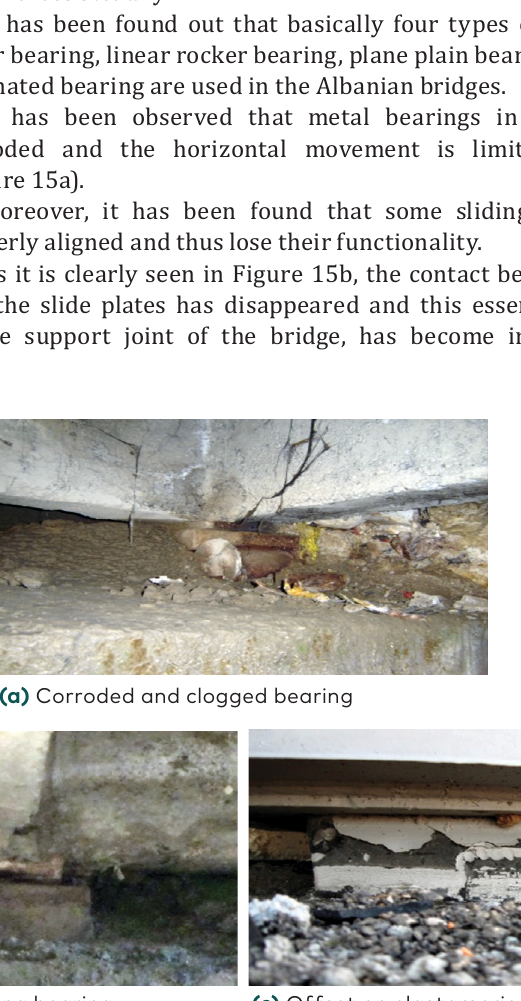
Figure 15. Common bearing